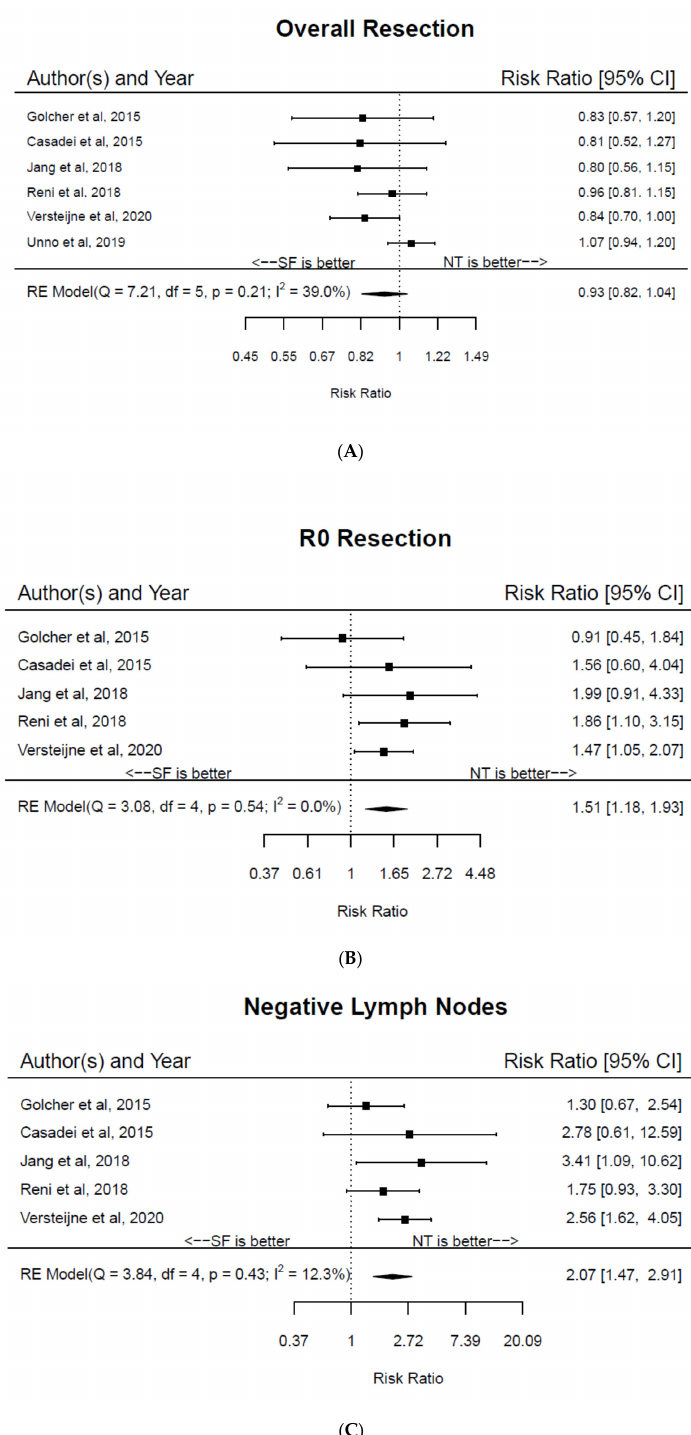
Figure 3. Forest plots of pooled relative risk ratios for ( A ) overall resection rates, ( B ) R0 resection rates, and ( C ) lymph node negative rates among patients with pancreatic cancer randomized to neoadjuvant therapy versus surgery first.